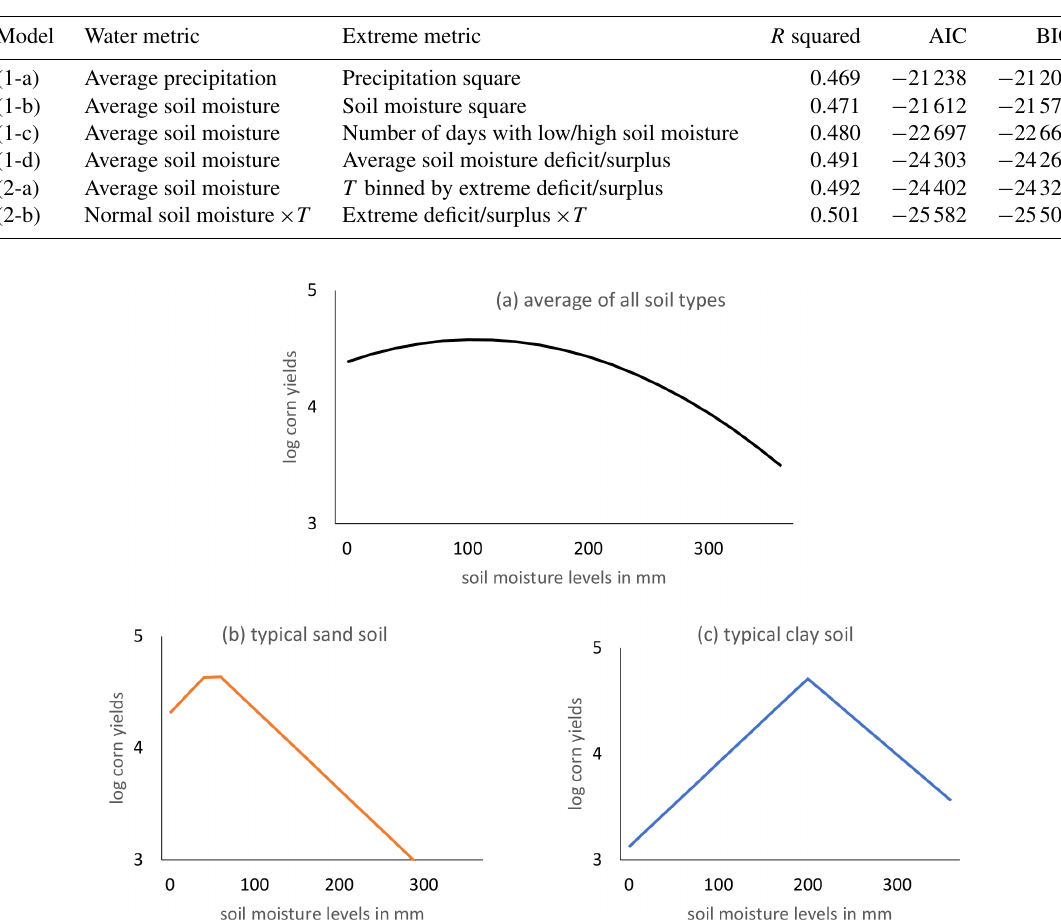
Table 5. Performance metrics for Models (1-a–d) and (2-a–b).